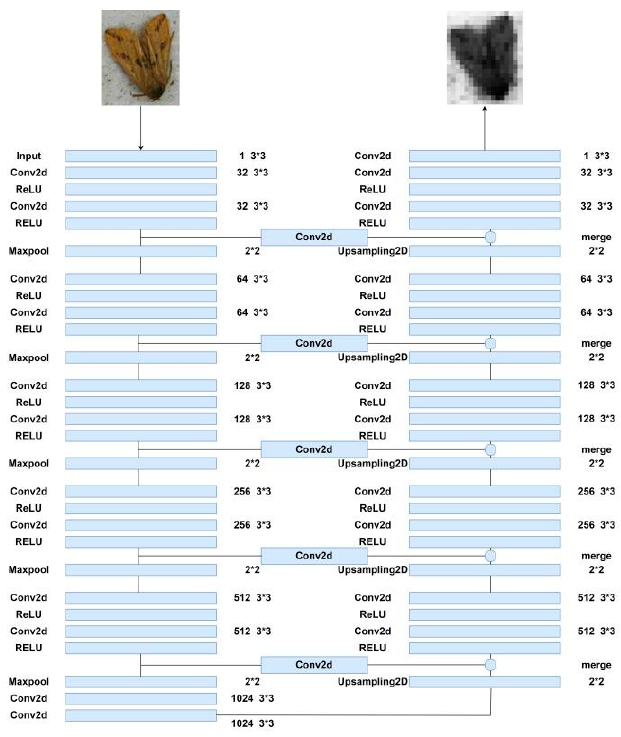
Figure 4. Deep convolutional encoder–decoder network structure diagram.